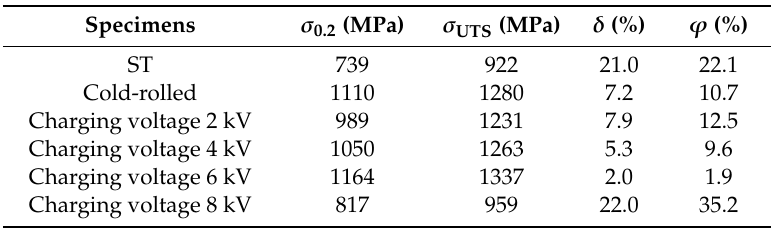
Table 1. Mechanical properties of the ST specimen, cold-rolled specimen, and electropulsing-treated specimens.